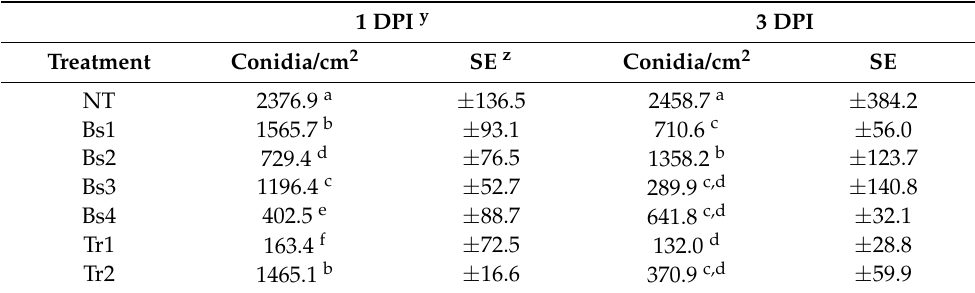
Table 3. Effect of curative applications of biological control agents (BCAs) on Stemphylium vesicarium conidia production. BCAs used were Bacillus subtilis strains (Bs1, Bs2, Bs3, Bs4) and Trichoderma spp. strains (Tr1, Tr2), applied 1 or 3 days post-inoculation. NT: non-treated control. Means with the same letter in each experiment are not significantly different according to Fisher’s protected least significant difference test ( p < 0.01). 1 DPI y 3 DPI Treatment Conidia/cm 2 SE